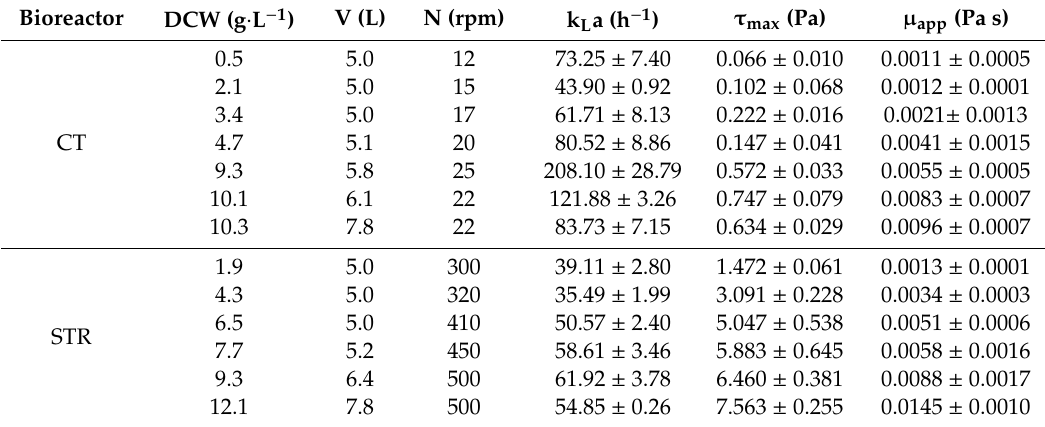
Table 1. Biomass as dry cell weight (DCW), culture volume (V), agitation velocity (N), volumetric mass transfer coe ffi cient (k L a), maximum shear stress ( τ max ), and apparent viscosity ( µ app ) of fermentation broths in STR and CT cultivations.